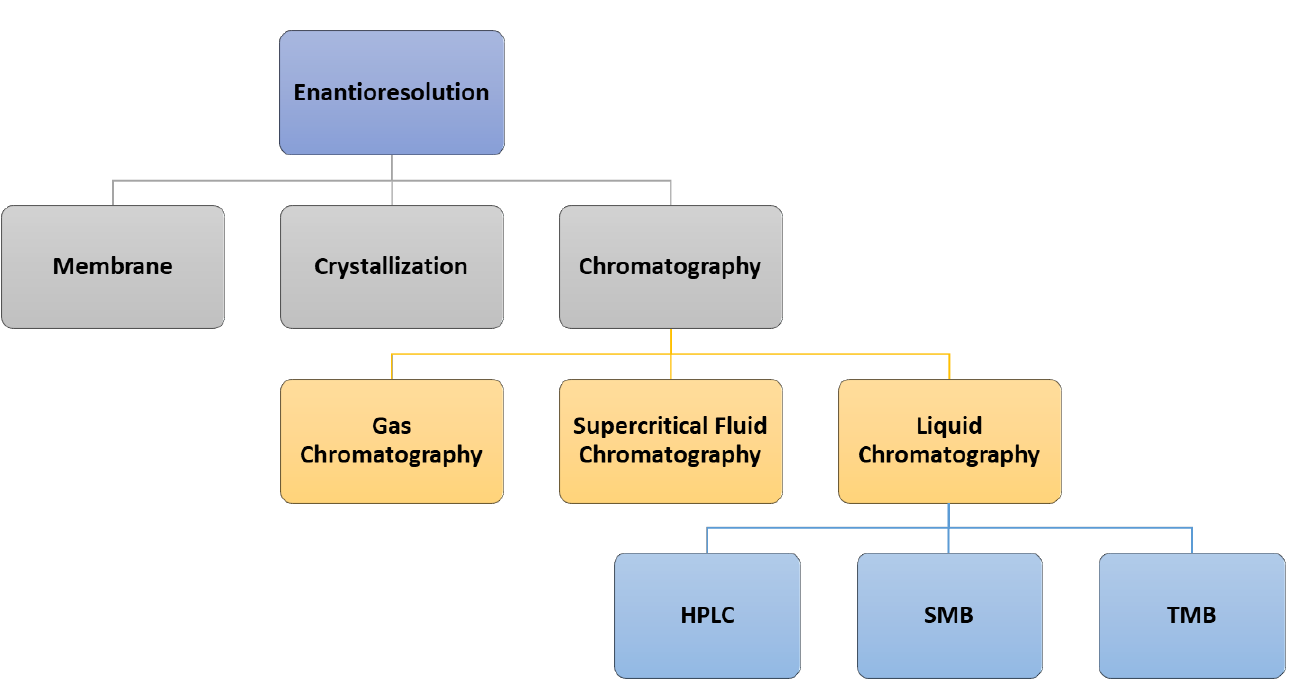
Figure 9. Main methods for enantiomer separation.